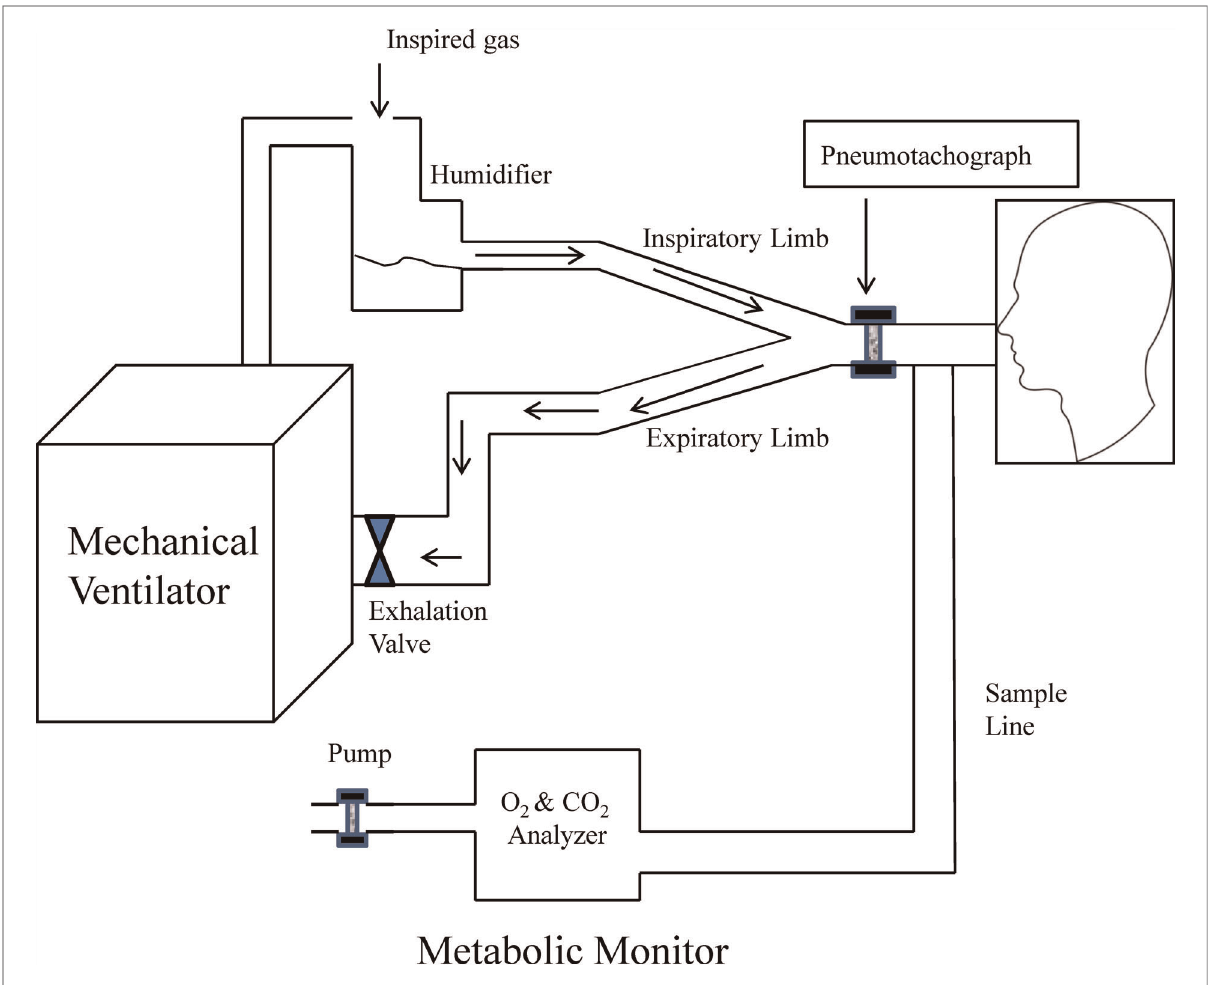
FIGURE 2 Graphic representation of metabolic equipment with breath-by-breath analysis and its interface with mechanical ventilation. Modi fi ed from Weissman and Kemper (33).